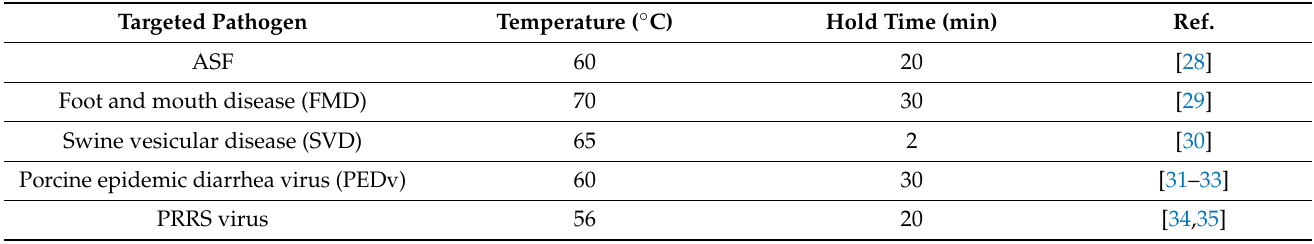
Table 1. Inactivation temperature and hold time needed for targeted swine pathogens